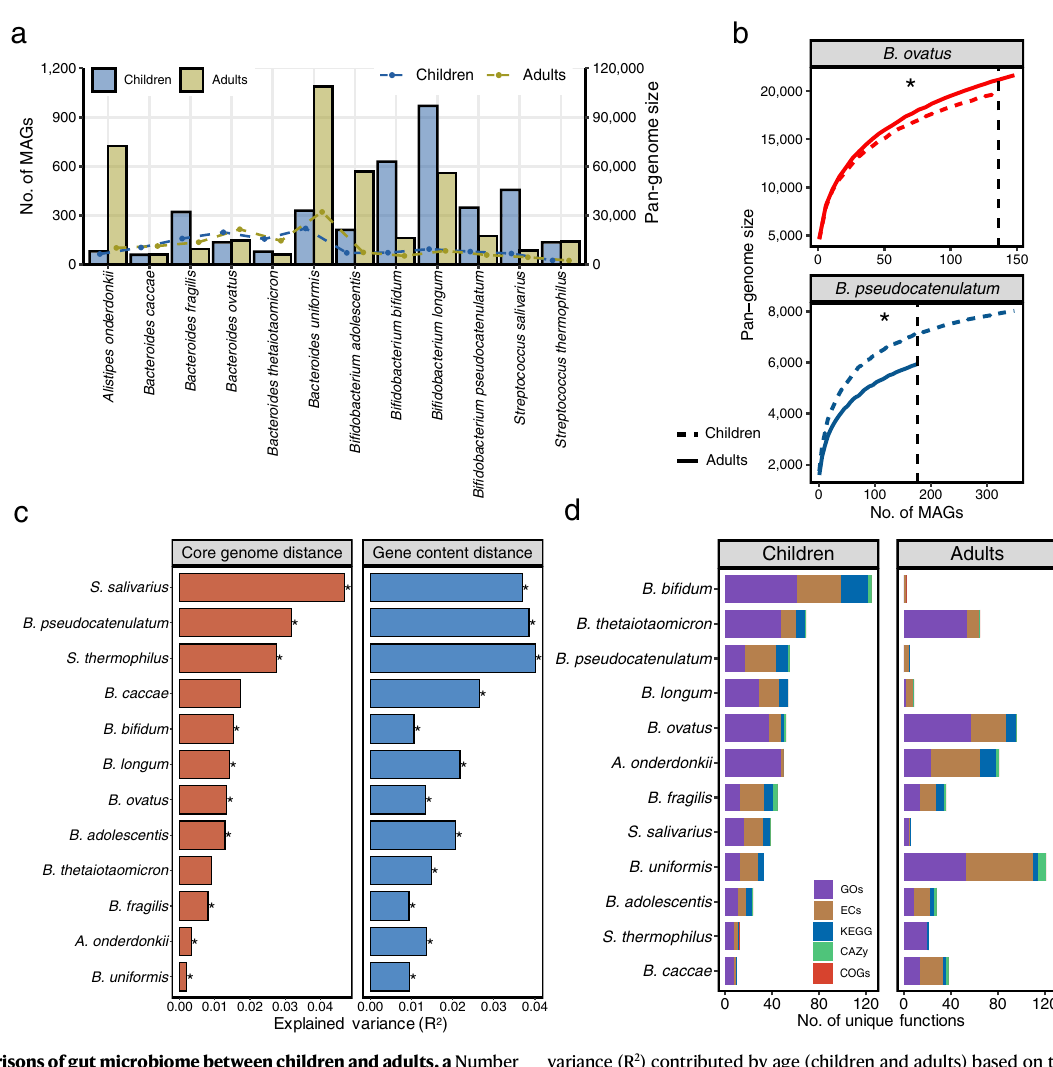
variance (R 2 ) contributed by age (children and adults) based on the hamming dis- tance of core genes per species and Jaccard distance of presence/absence genes (two-tailed Wilcoxon test, *FDR<0.05). d The unique functional annotations belonging to either children or adults categorized by databases of COGs, KEGG, GOs, ECs, and